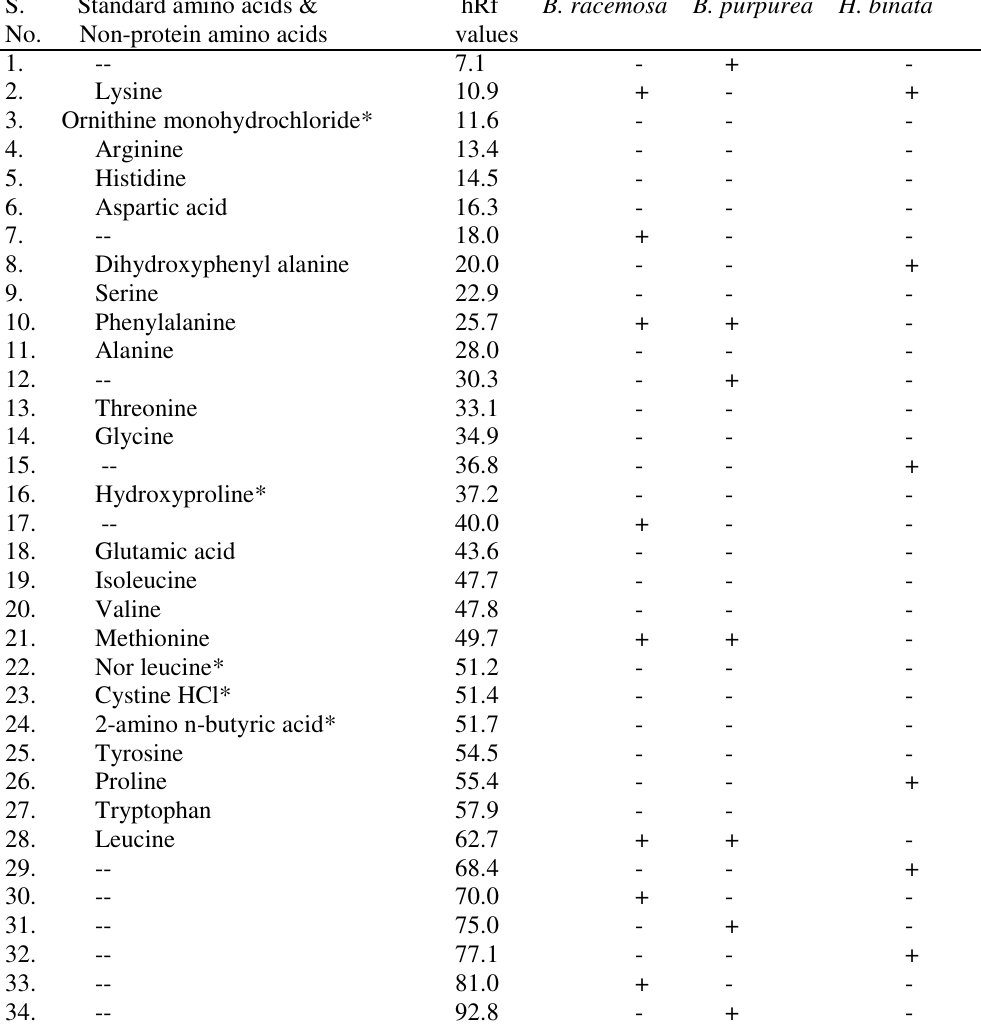
Table-5 . Qualitative separation of amino acids and non protein amino acids